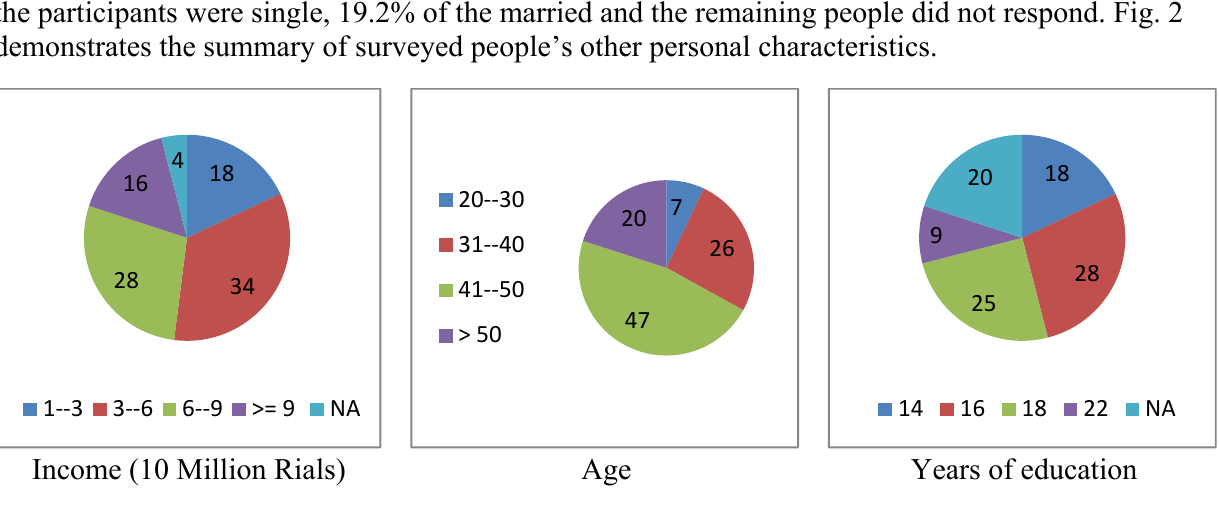
Fig. 2. Personal characteristics of the